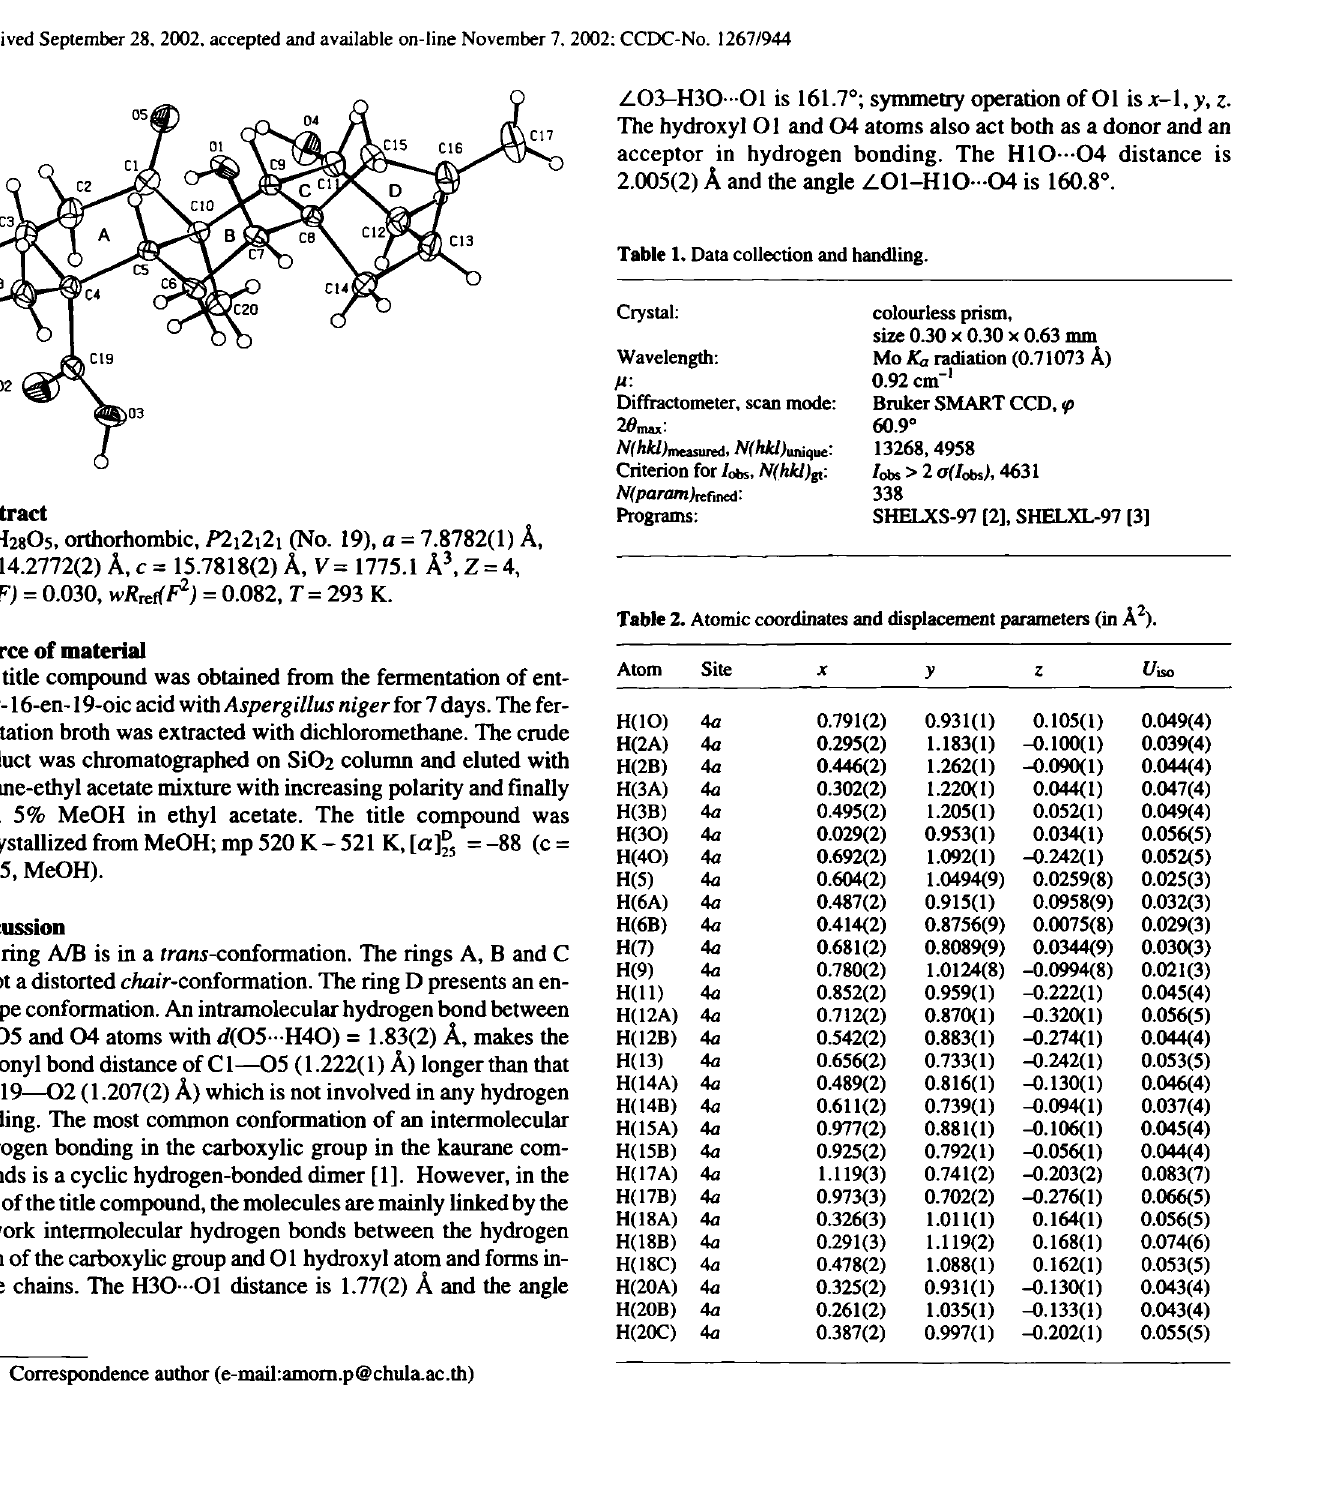
Table 1. Data collection and handling.